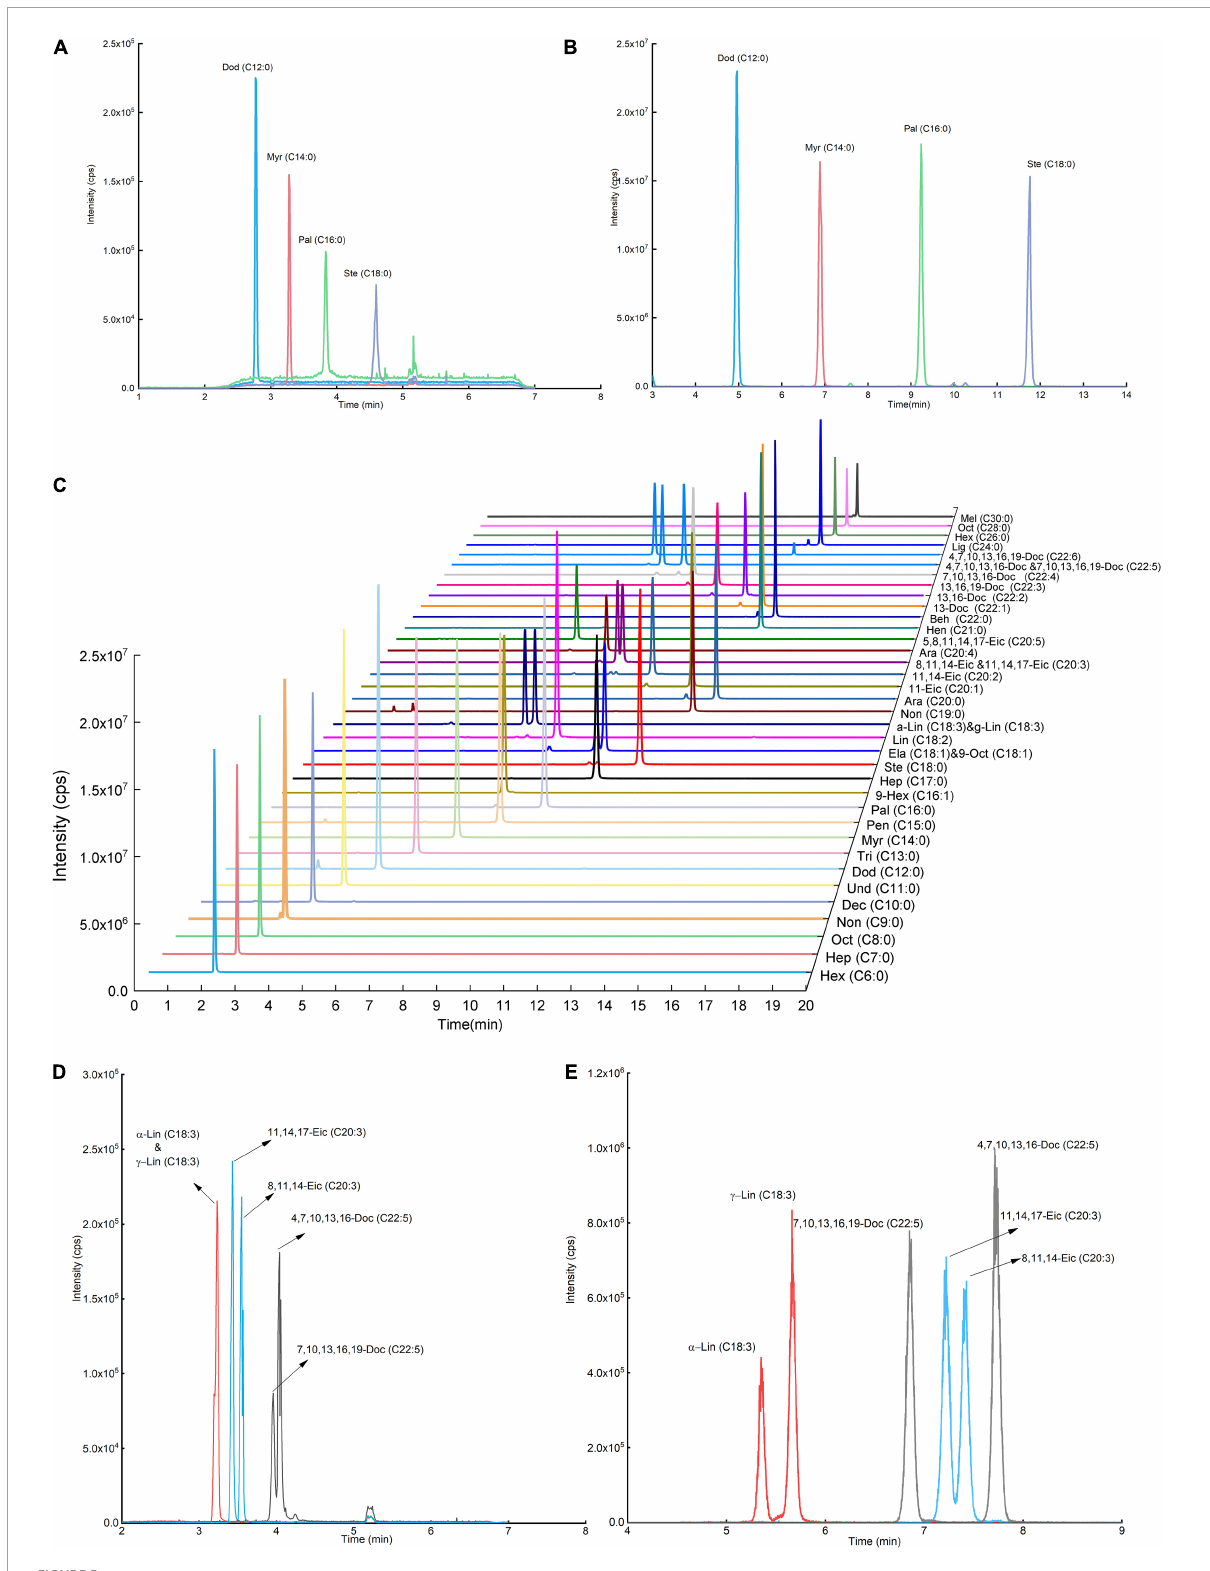
FIGURE5 Sensitivity evaluation before (A) and after (B) fatty acid (FA) derivatization reaction. Liquid chromatograph (LC) chromatograms of (C) 5-(dimethyamino)-1-carbohydrazide isoquinoline (DMAQ)-derivatized FA standards with different carbon-chain length. The relationship LC chromatograms of isomer FA standards (D) before and (E) after